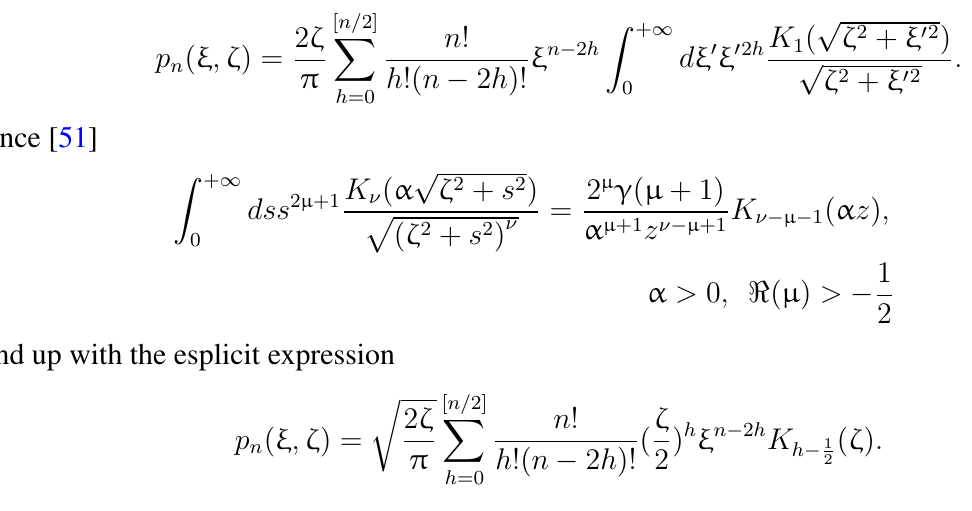
( ξ , ζ ) | (red solid line), ψ G nr ( ξ , ζ , ε = 2) (magenta dash-dotted line), and D